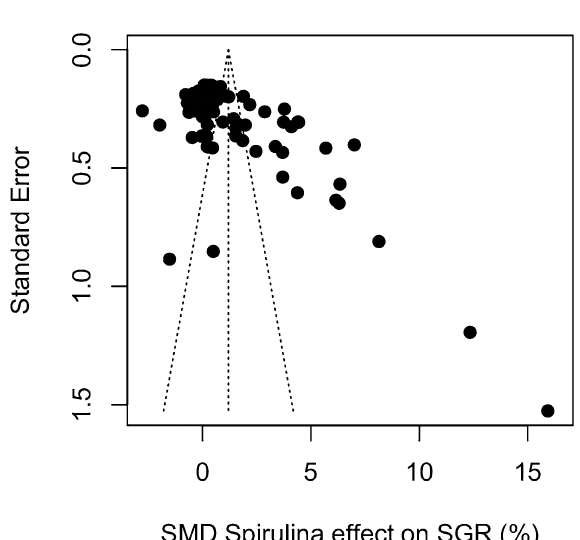
Figure 4. Funnel plot showing the relationship between the SMD and the standard error (inverted scale) for the effects of Spirulina replacement on specific growth rate (SGR). Each point represents a treatment–control comparison and the dotted vertical line denotes the global SMD under a random effects model. An asymmetric distribution of points outside the funnel might be indicative of publication